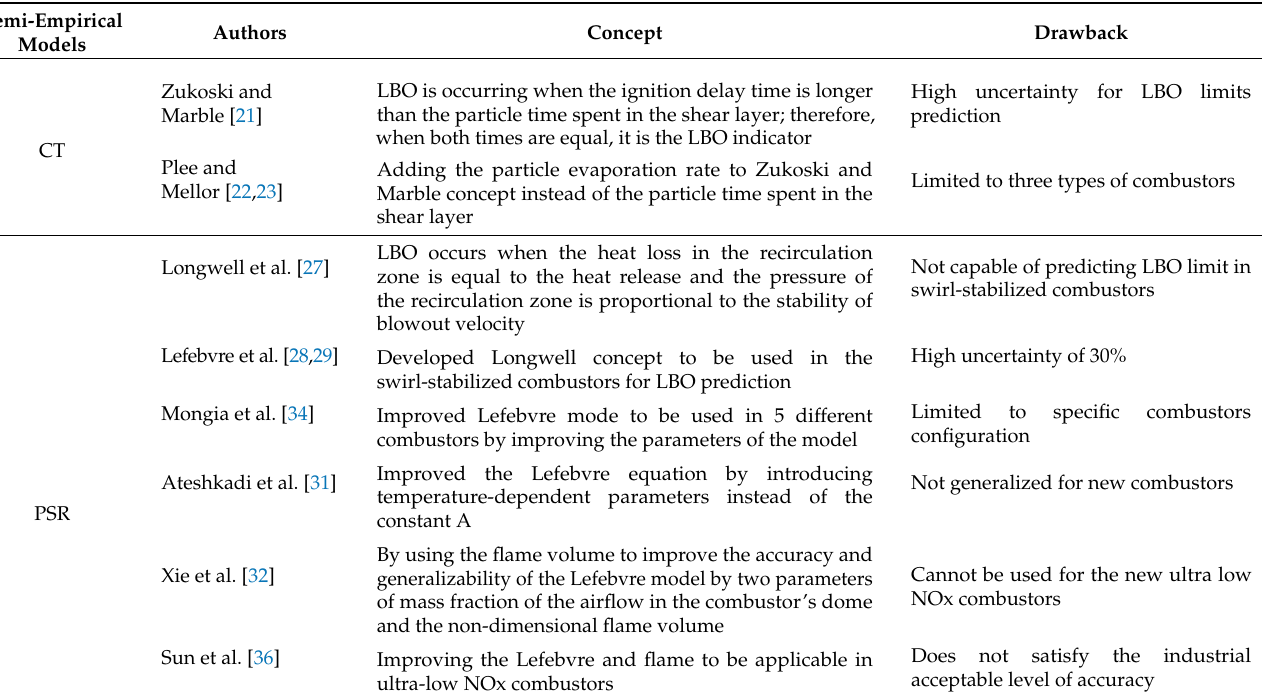
Table 1. Development stages of the semi-empirical approach.